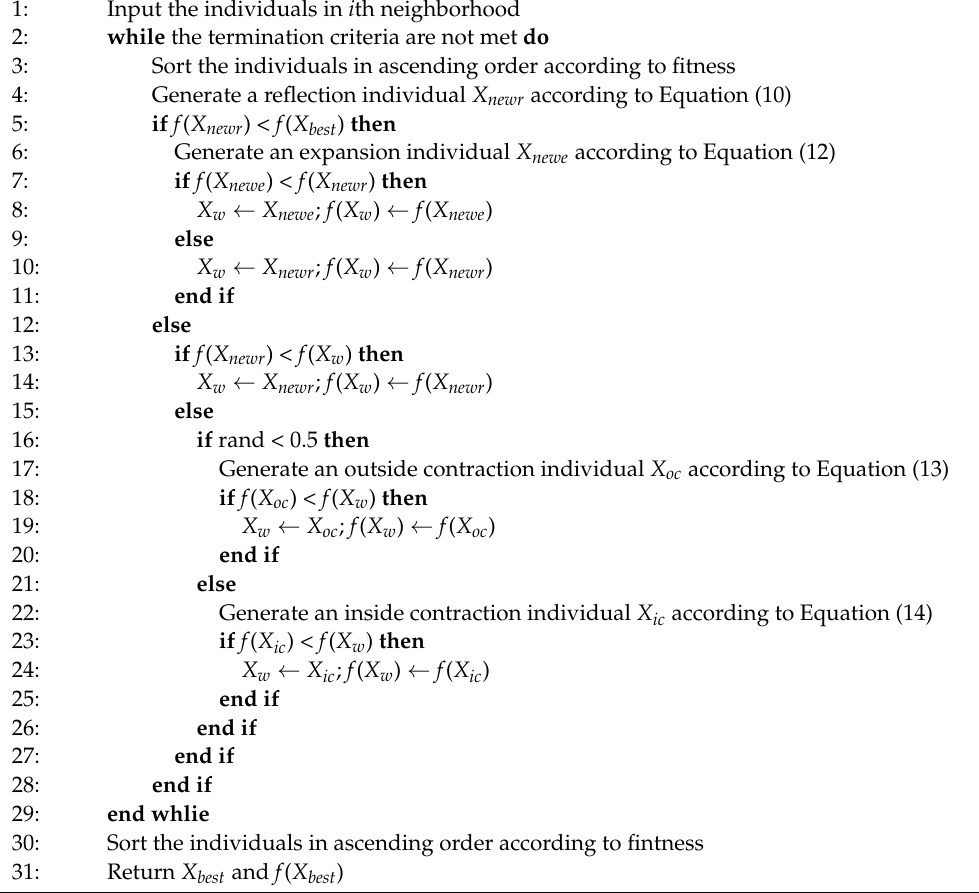
Algorithm 2 Modified Nelder–Mead updating